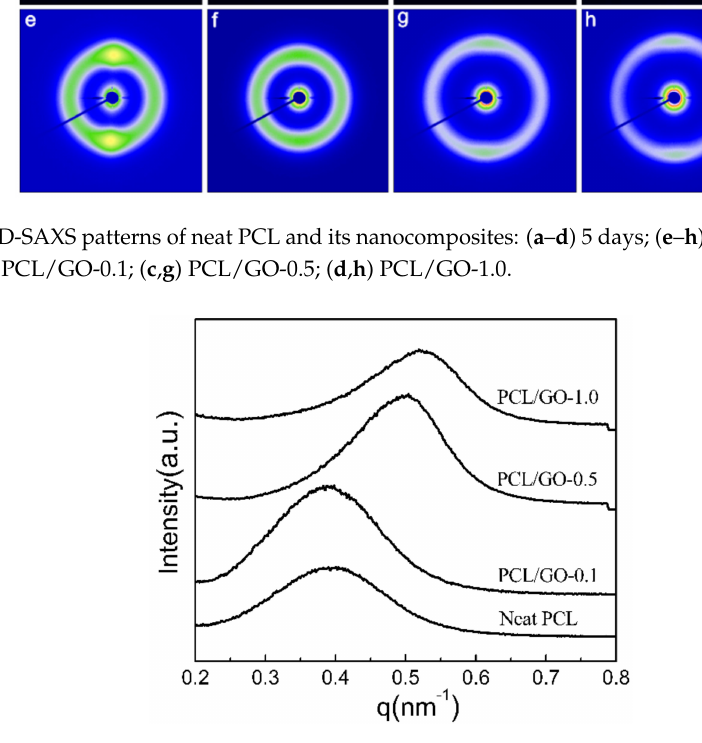
Figure 2. Radially integrated profiles of neat PCL and its nanocomposites collected from the corresponding 2D-SAXS patterns after leaving 50